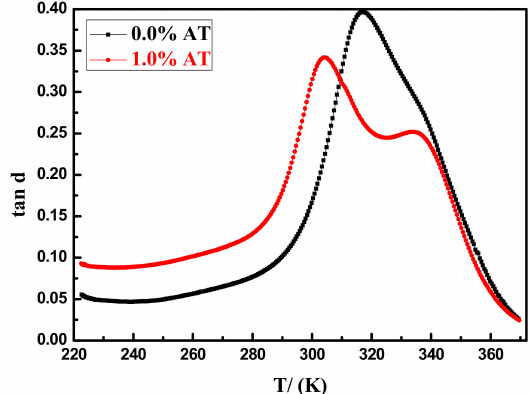
Figure 11. The dynamic thermomechanical analysis (DMA) curves of epoxy coating with 0.0% and 1.0%